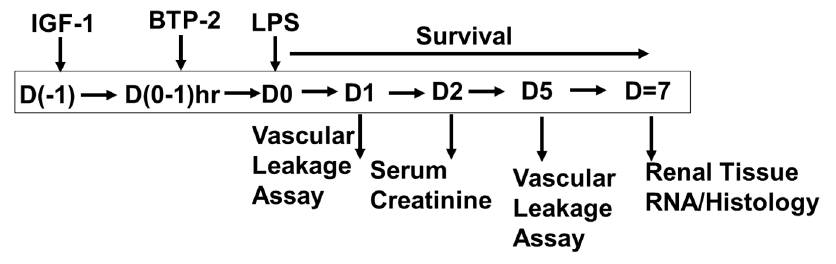
Figure 1. Experimental design for acute kidney injury (AKI) parameters such as survival, serum IGF-1 rescue and gene expression analysis in lipopolysaccharide (LPS) induced AKI animals treated with IGF-1 and BTP-2.